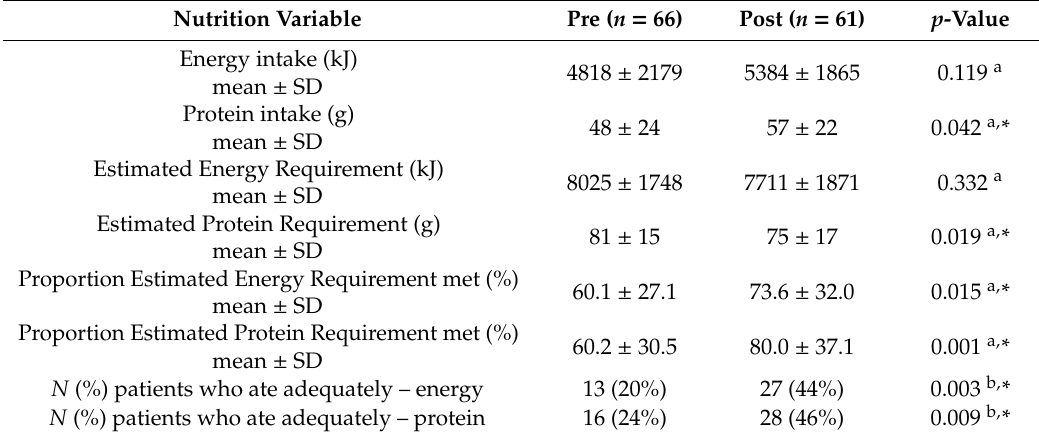
Table 2. Patients’ energy and protein intakes and requirements pre and post implementation.